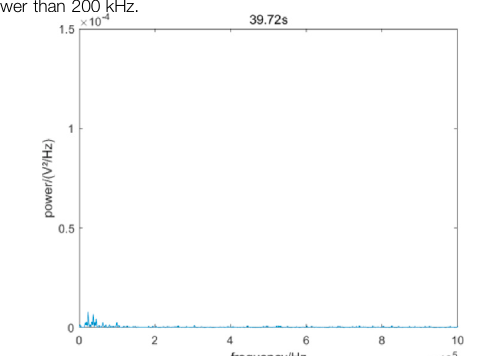
There is no magnetic fl uid fl ow in 16.2 s. All the measured signals are noise, and its frequency is concentrated in the